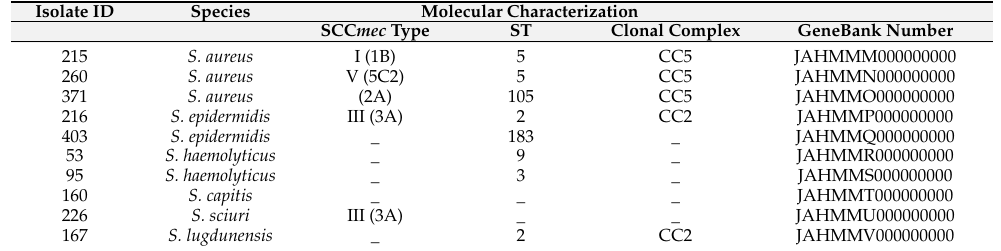
Table 2. Molecular epidemiology of Staphylococcus spp. clinical isolates included in the